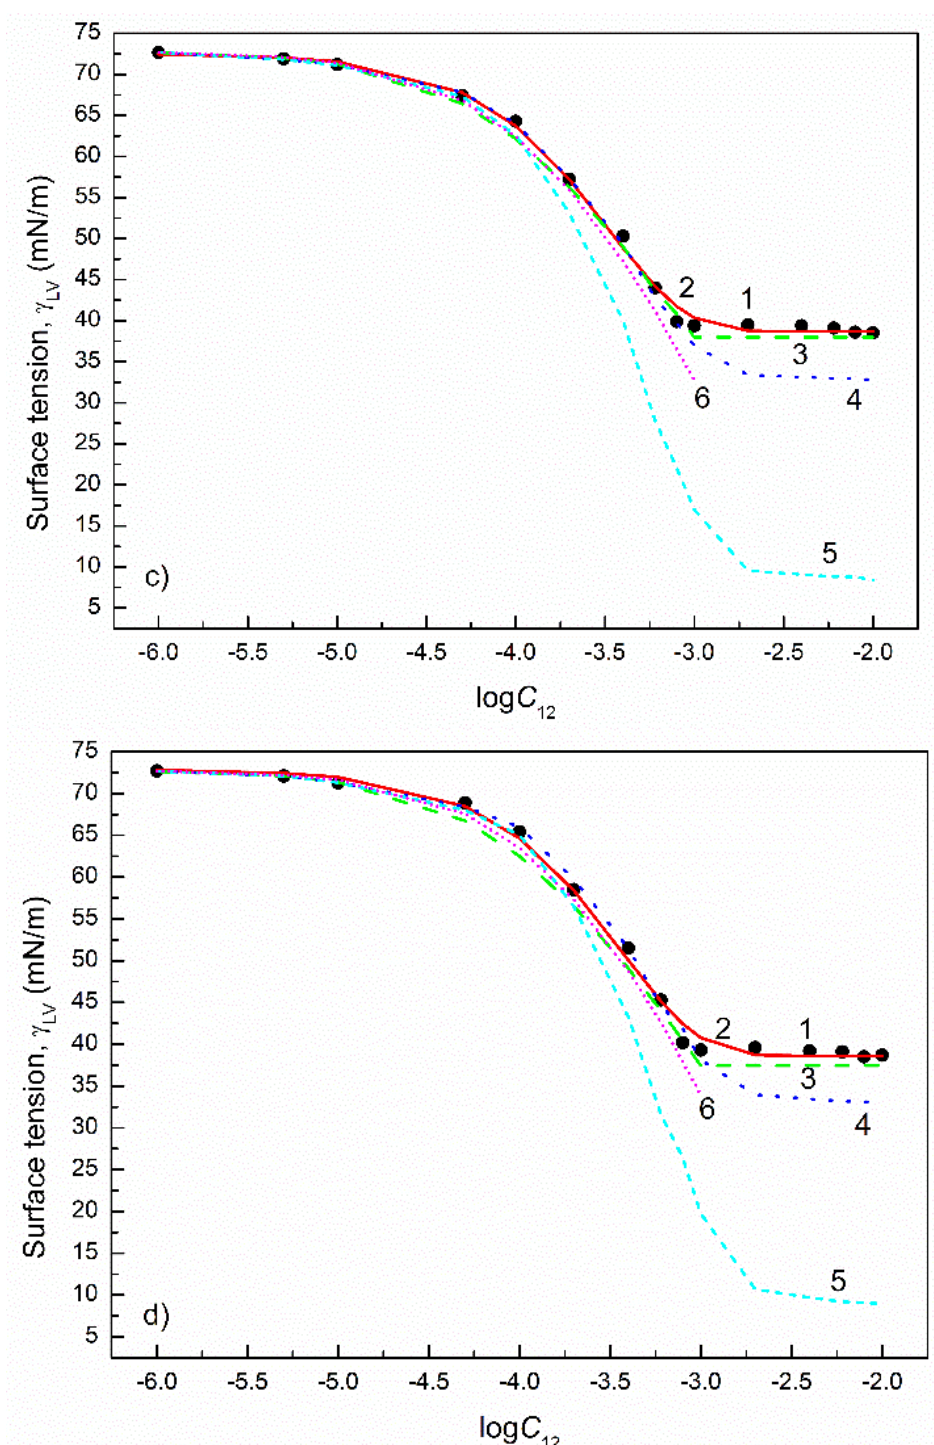
Figure 5. A plot of the surface tension ( γ LV ) of the aqueous solutions of CTAB+CPyB mixtures at the CTAB mole fraction in the bulk phase ( α ) equal to 0.2 ( a ), 0.4 ( b ), 0.6 ( c ) and 0.8 ( d ) vs. the logarithm of the mixture concentration ( logC 12 ). Points 1 correspond to the measured values [21], curves 2–6 correspond to the values calculated from the exponential function of the second order (Equation (2)), Szyszkowski equation (Equation (3)), Fainerman and Miller equation (Equation (11)), independent adsorption (Equation (10)) and Joos equation (Equation (13)), respectively.